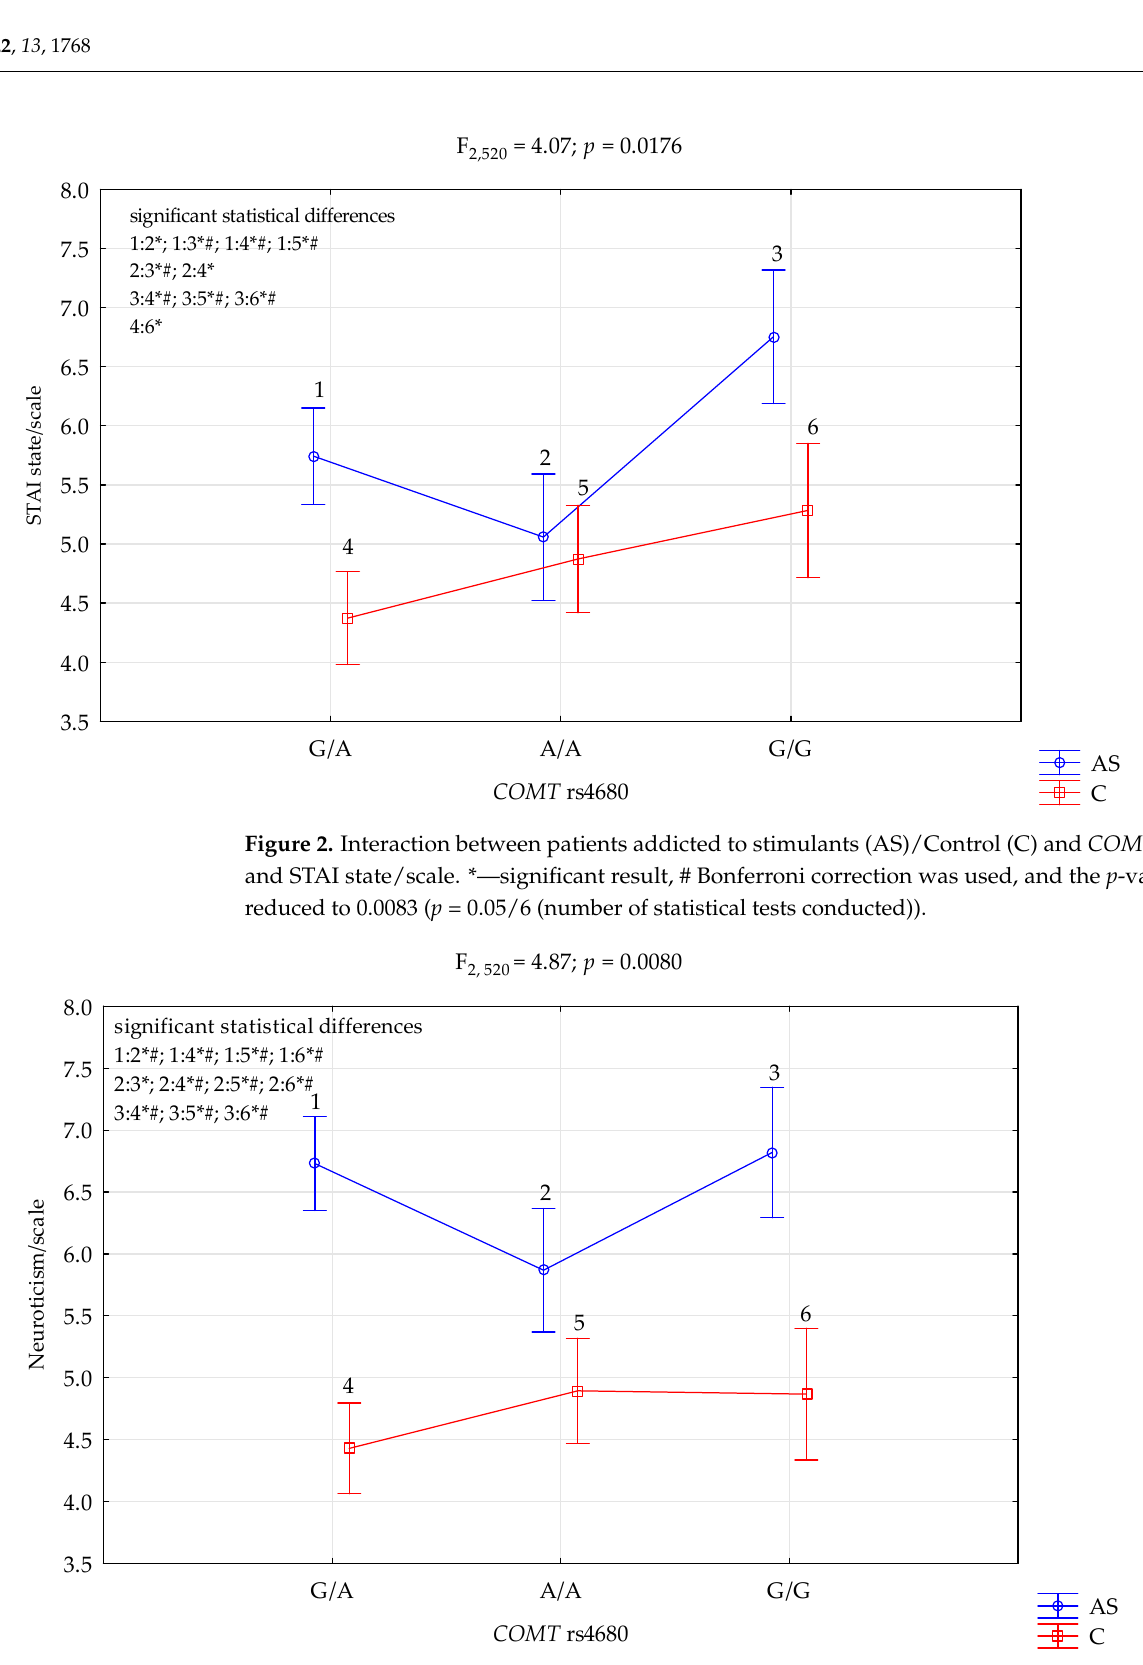
Figure 3. Interaction between patients addicted to stimulants (AS)/Control (C) and COMT rs4680 and Neuroticism scale. *—significant result, # Bonferroni correction was used, and the p -value was reduced to 0.0083 ( p = 0.05/6 (number of statistical tests conducted)).